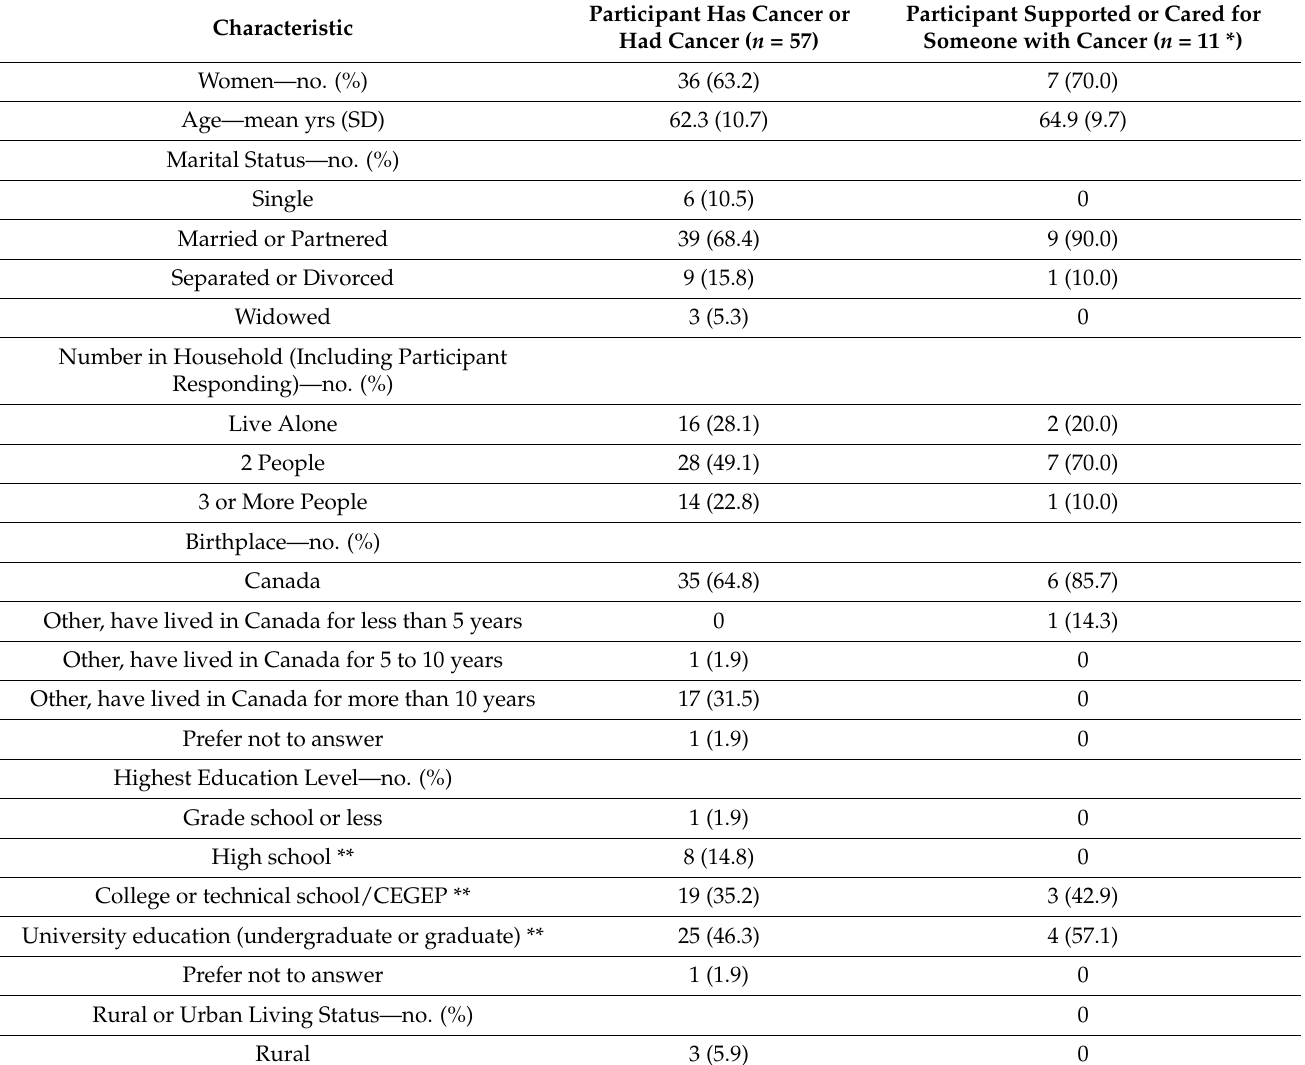
Table 2. Characteristics of focus group participants. Percentages are calculated based on the number of participants who responded in each